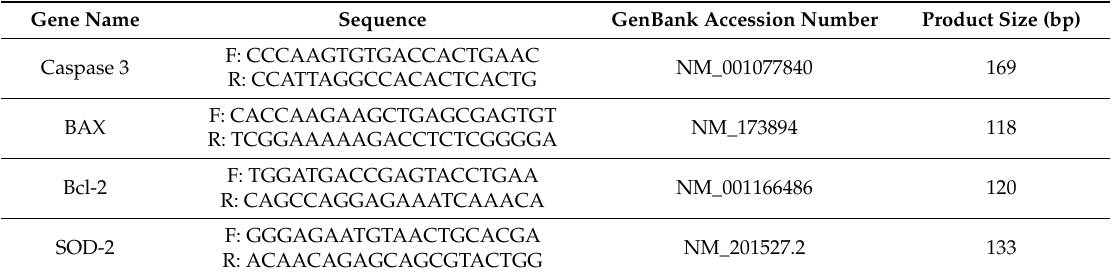
Table 1. Genes names, accession numbers, the sequences of primers used in RT-qPCR, and sizes of PCR